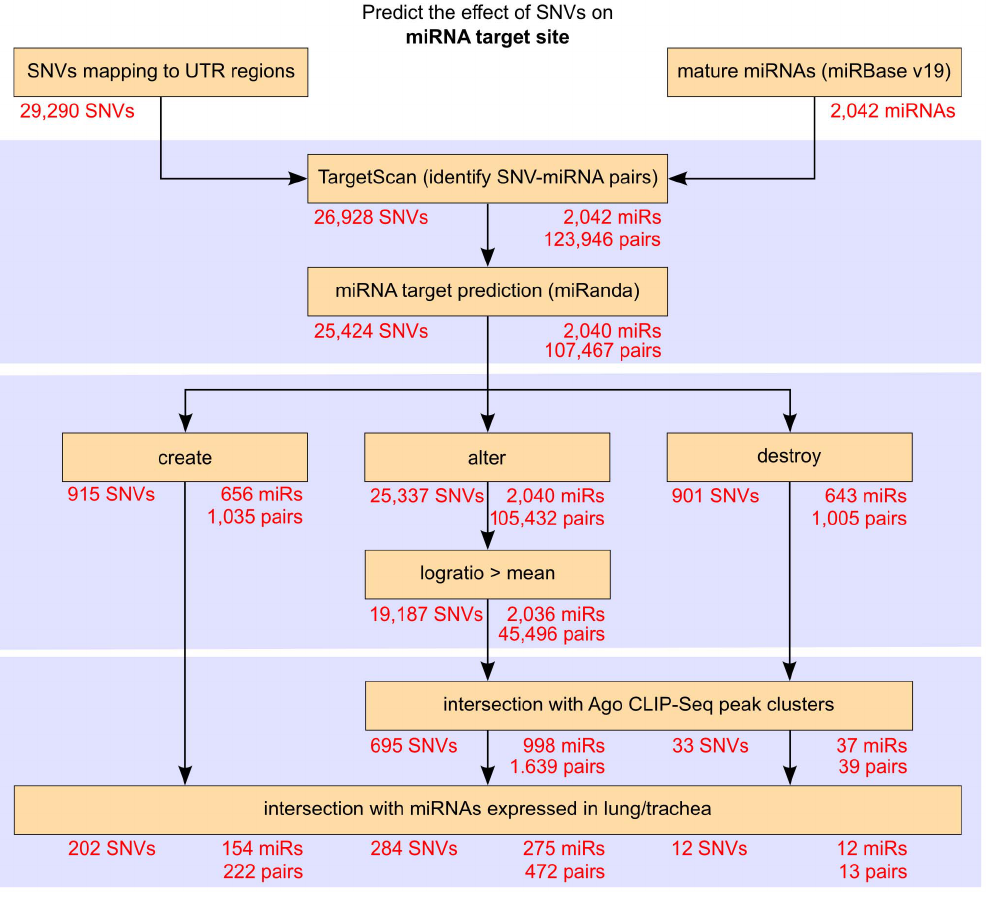
Figure 2. Pipeline for the analysis of SNVs’ effect on miRNA target sites in more detail (dashed box from Figure 1). The flow chart shows the different steps of prediction and filtration with the number of individual SNVs, miRNAs, and pairs of these at each stage.